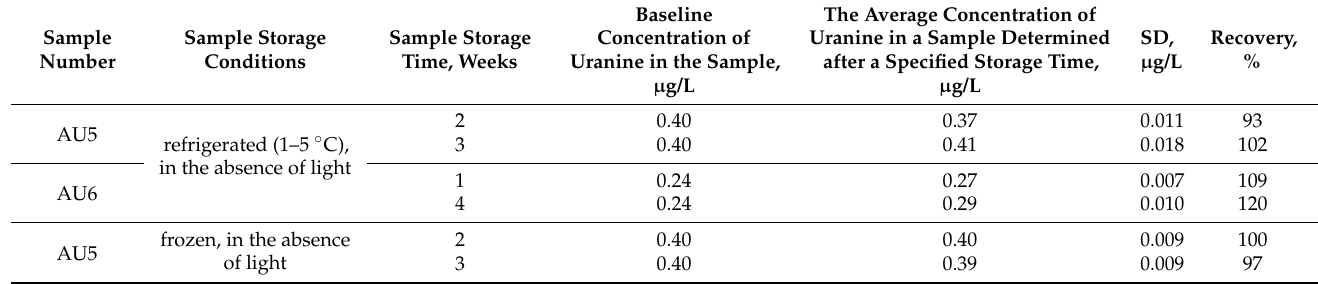
Table 8. Results obtained in determining the stability of enriched real samples during storage.